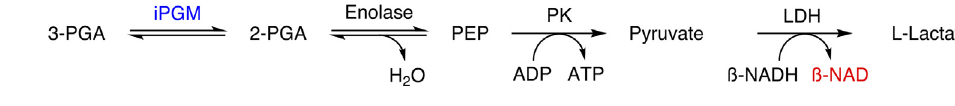
Figure 2. Scheme for assaying the enzymatic activity of phosphoglycerate mutase (iPGM) [15].